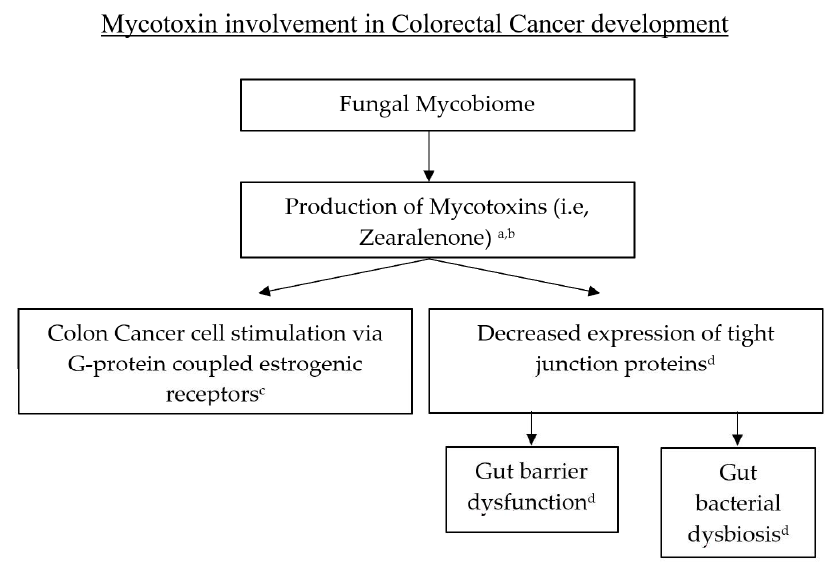
Figure 4. Mycotoxins can lead to CRC development through G-protein coupled estrogenic receptors or via gut barrier disruption and gut bacterial dysbiosis. a -Omotayo et al., b -Buszewska-Forajita et al., c -Lo et al., d -Zhang et